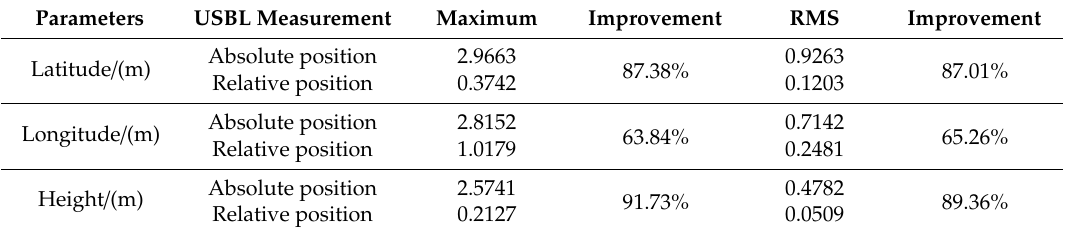
Figure 11. Description of the navigation errors in the semi-physical experiment. Table 5. The grid SINS/DVL/USBL integrated navigation position errors.